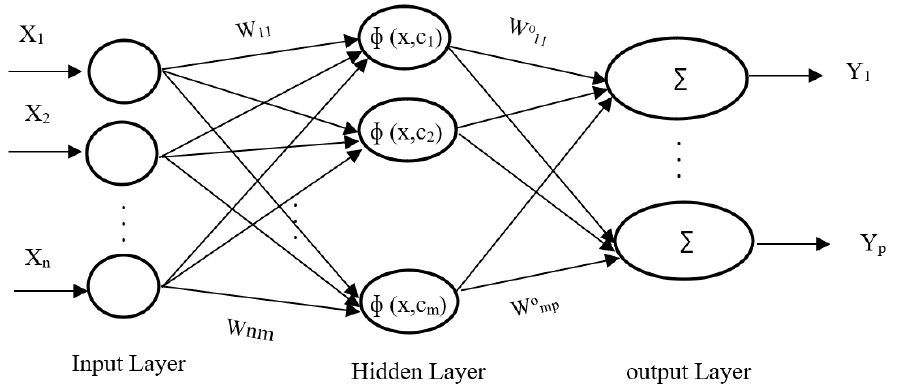
Figure 2. RBF model.